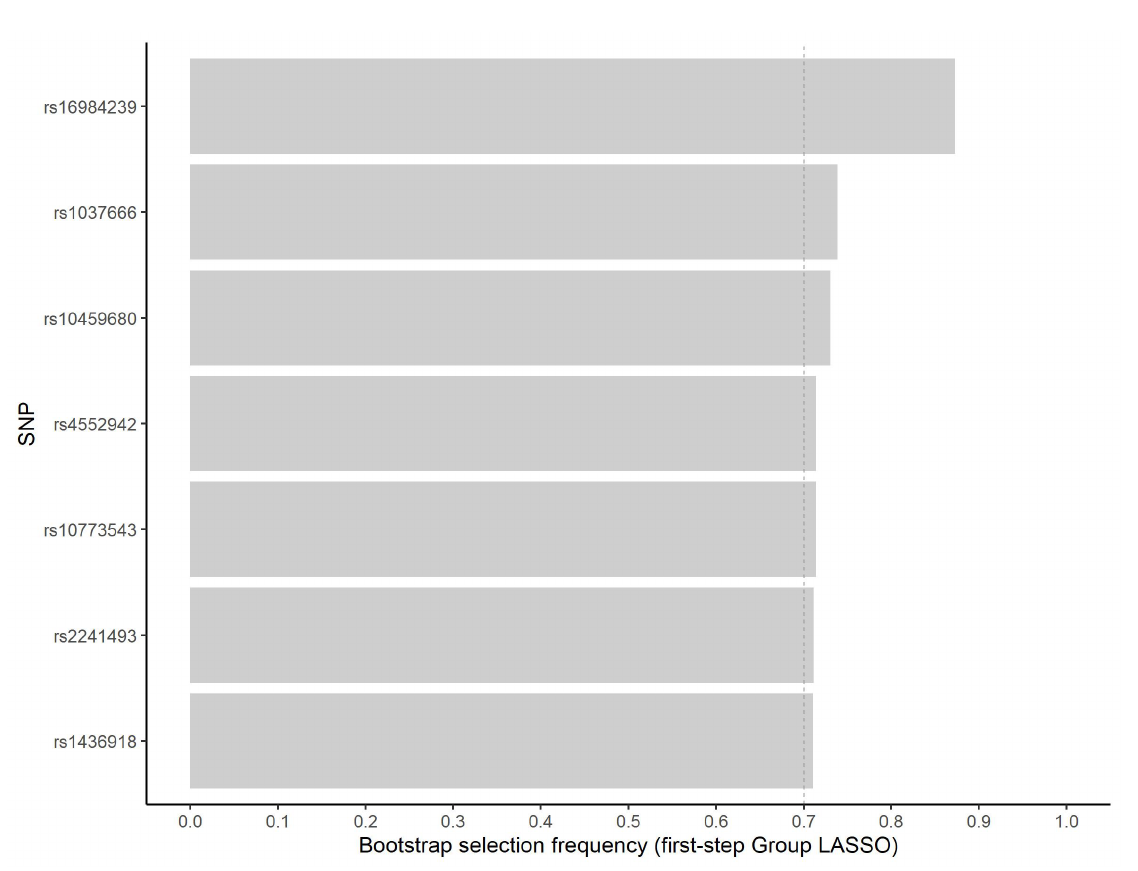
Figure 1. Frequency of non-zero estimated coefficient for the seven most frequently selected variants in the first step group LASSO regularization.